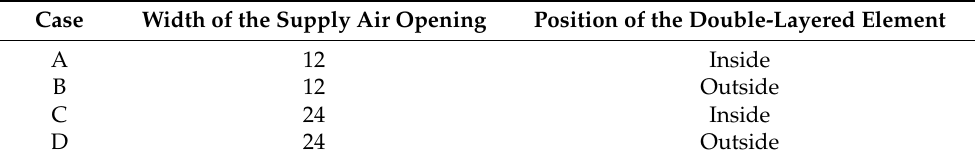
Table 7. Summary of the simulated configurations (width of the inlet opening was assumed to be 12 mm in all cases).